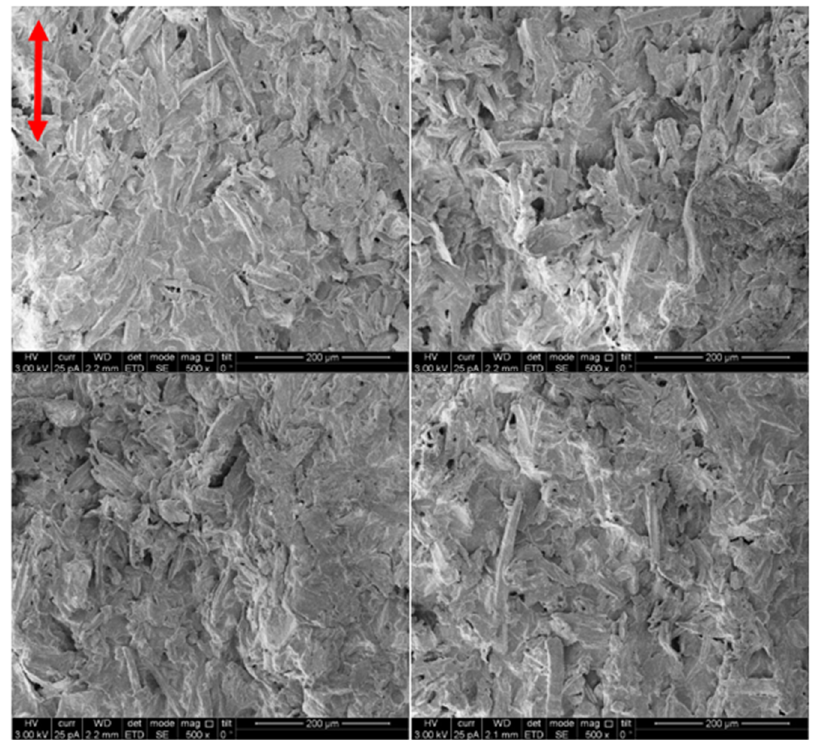
→ ⃗ = 600 mm min ⁄ ⃗ = 600 mm min ⁄ v = 600mm/min (arrows indicating (arrows indicating (arrows indicating